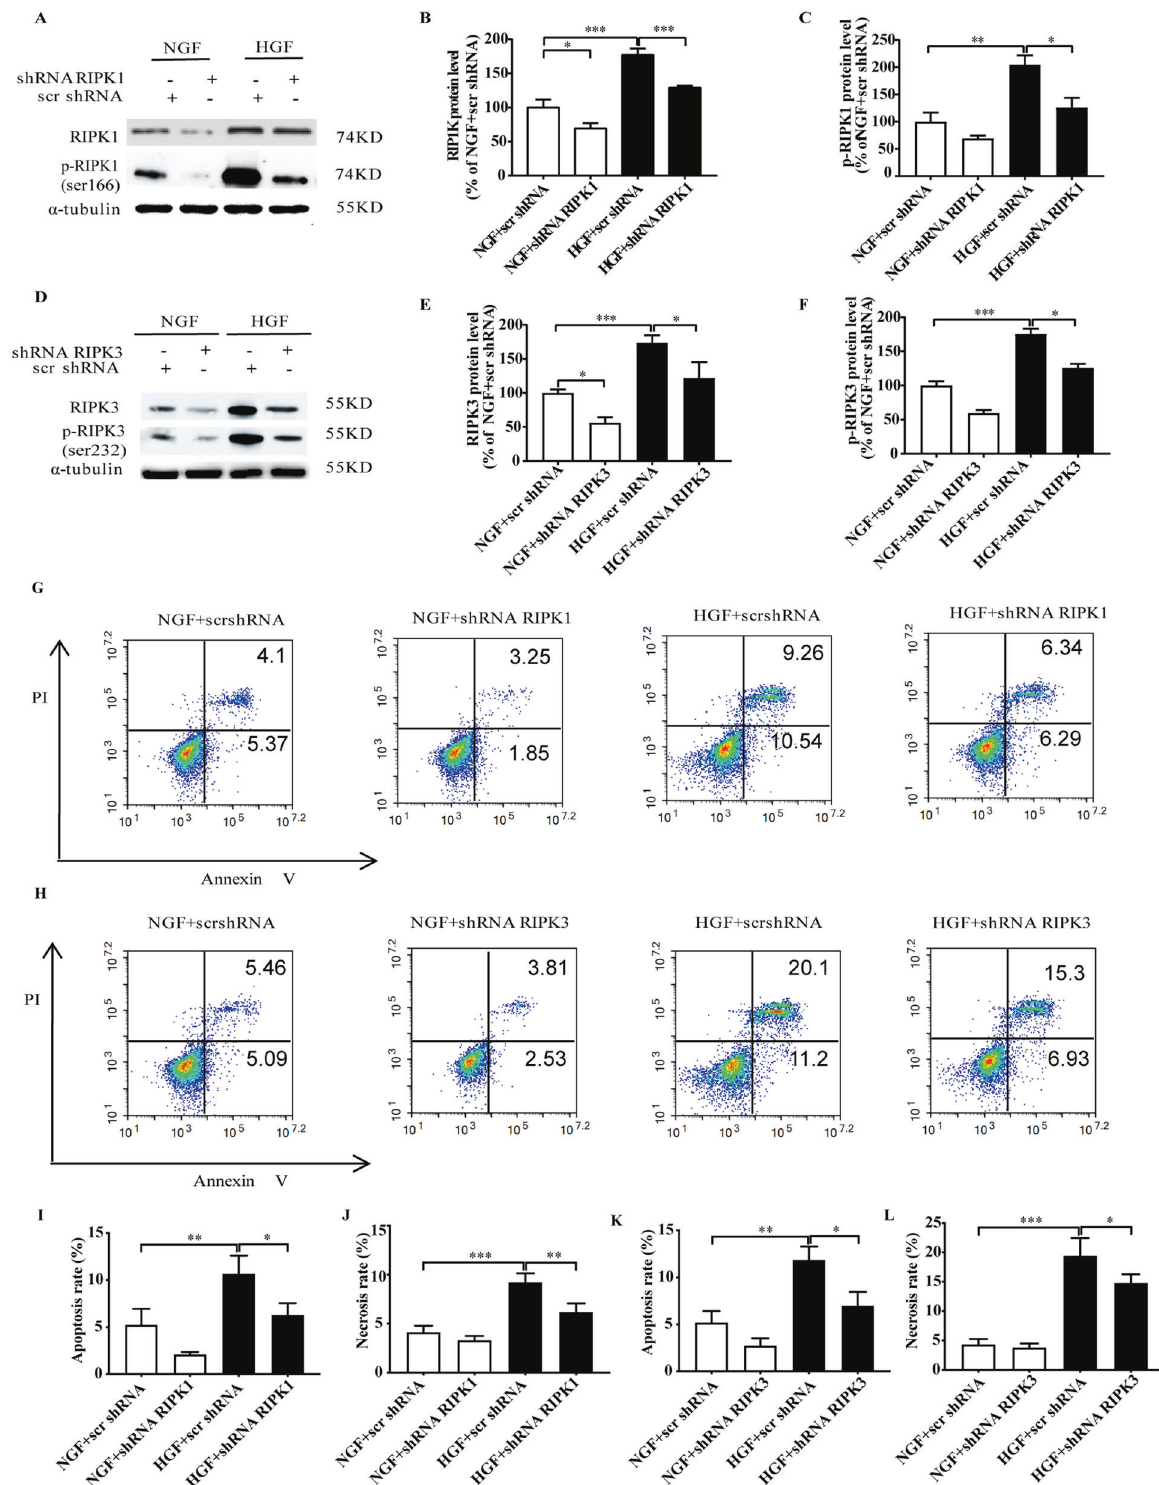
Fig. 1 RIPK1/RIPK3 silencing inhibited HGF-induced necroptosis. Representative images and percentages of RIPK1/ser166-p-RIPK1 ( A – C ) and RIPK3/ser232-p-RIPK3 ( D – F ). Percentages of apoptotic and necrotic cells ( G – L ). n = 3 per group. Means ± SD. * P < 0.05, ** P < 0.01, *** P < 0.001. NGF normal glucose and fat group, HGF high glucose and high fat